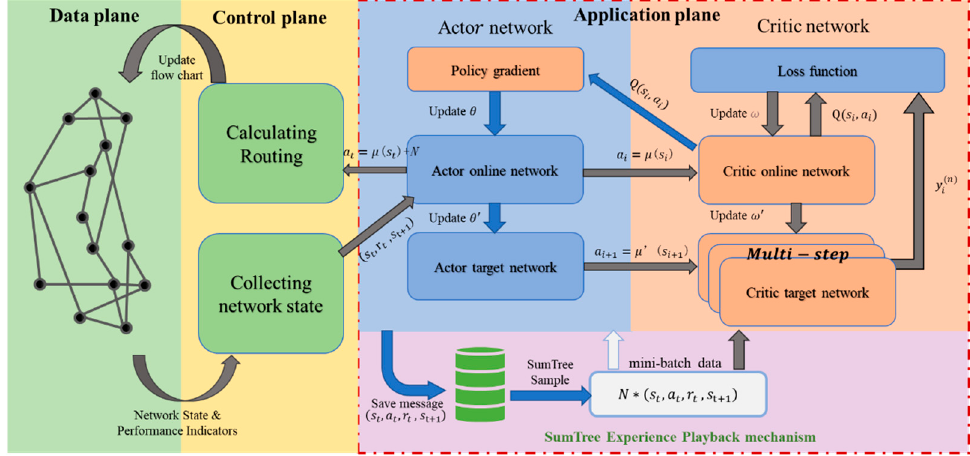
Figure 1. DRL-based QoS optimization architecture in SDN.